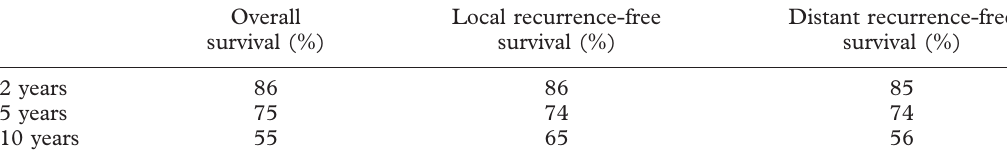
Table 1. Survival data of 86 patients with an initial irradical excision for soft tissue sarcoma Overall survival